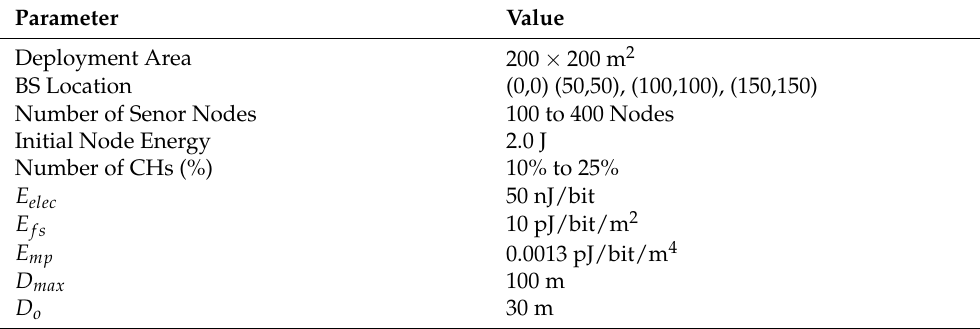
Table 3. Network simulation parameters.